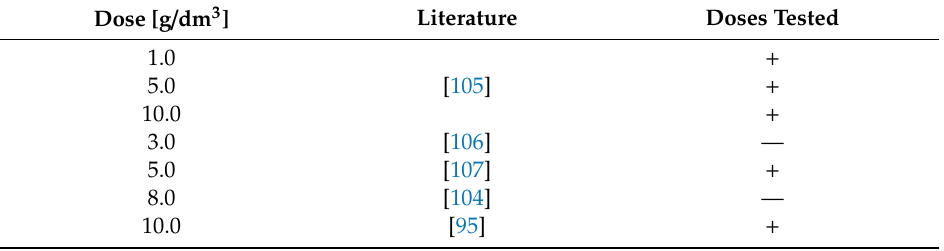
Table 4. Selected publications based on which doses of modified reactive materials were selected and used in the